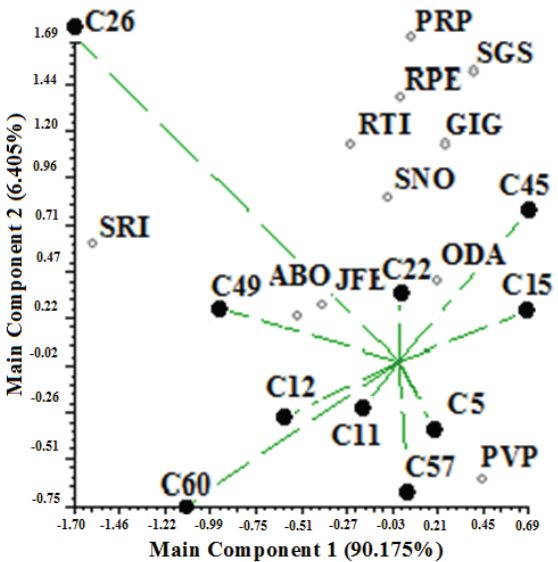
Figure 2 - Principal component analysis and two-dimensional scale dispersion of the ten major volatiles (a) of Lippia rotundifolia Cham. of 11 accessions belonging naturally occurring populations in Minas Gerais, Brazil. (5) α-pinene; (11) myrcene; (12) α-felandrene; (15) limonene; (22) linalool; (26) tagetone; (45) β- elemene; (49) caryophyllene; (57) germacrene; (60) α-selinene. SRI: Santana do Riacho in lapinha; PVP: Veredas do Peruaçu State Park; ODA: APA Olhos D´água; gIg: gigante Community in Botumirim; RPe: Rio do Peixe in Botumirim; ABO: Abóboras Community in Montes Claros; PRP: Rio Preto State Park; JFe: Serra geral in Joaquim Felício; SNO: Serra Nova State Park; RTI: Rio Tigre in gouveia and SgS: São gonçalo do Rio das Pedras in the Serro